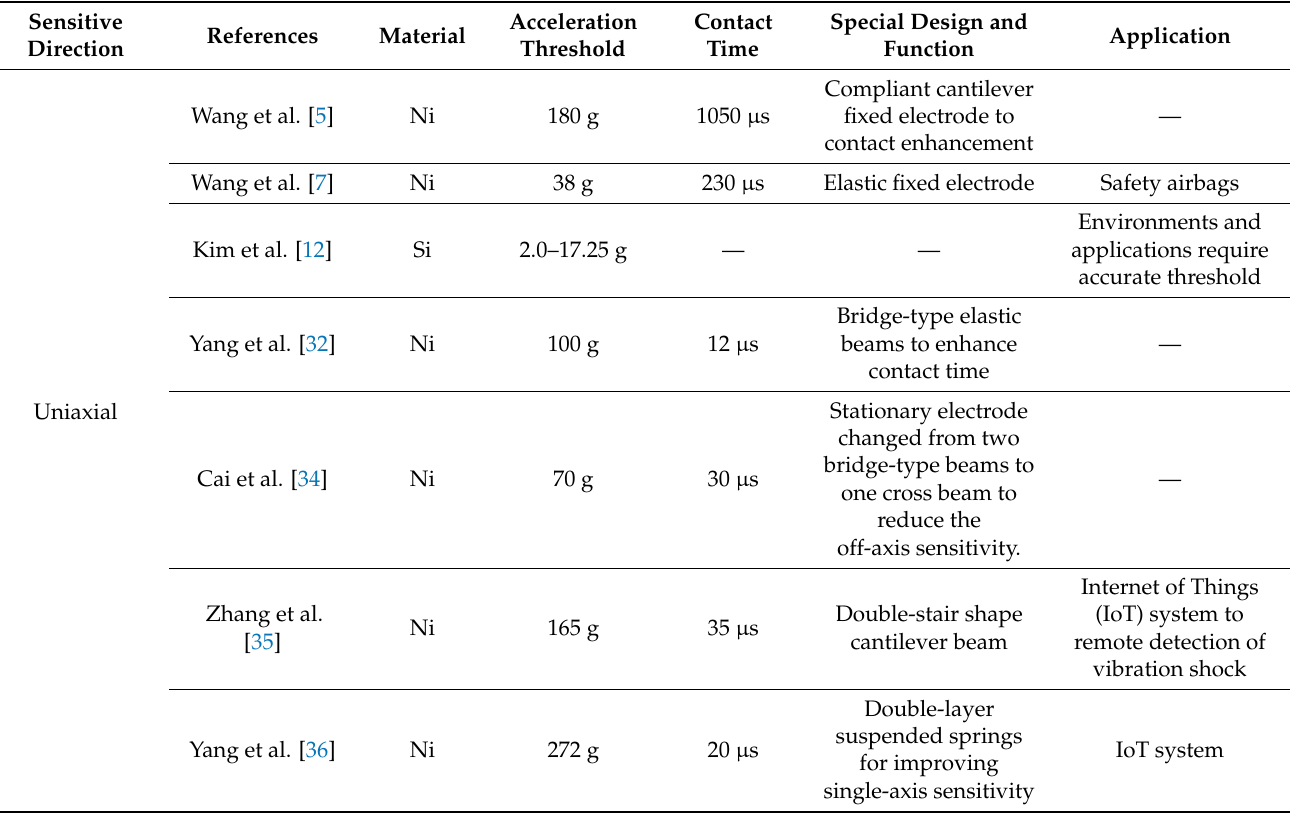
Figure 4. Structural sketch of the omnidirectional inertial switch. Table 1. A summary of some examples of typical sensitive direction inertial switch